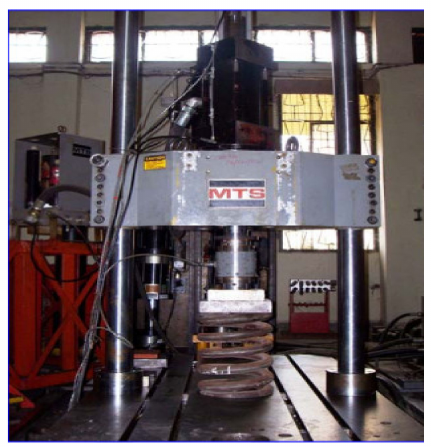
Figure 3. Experimental setup for testing a spring